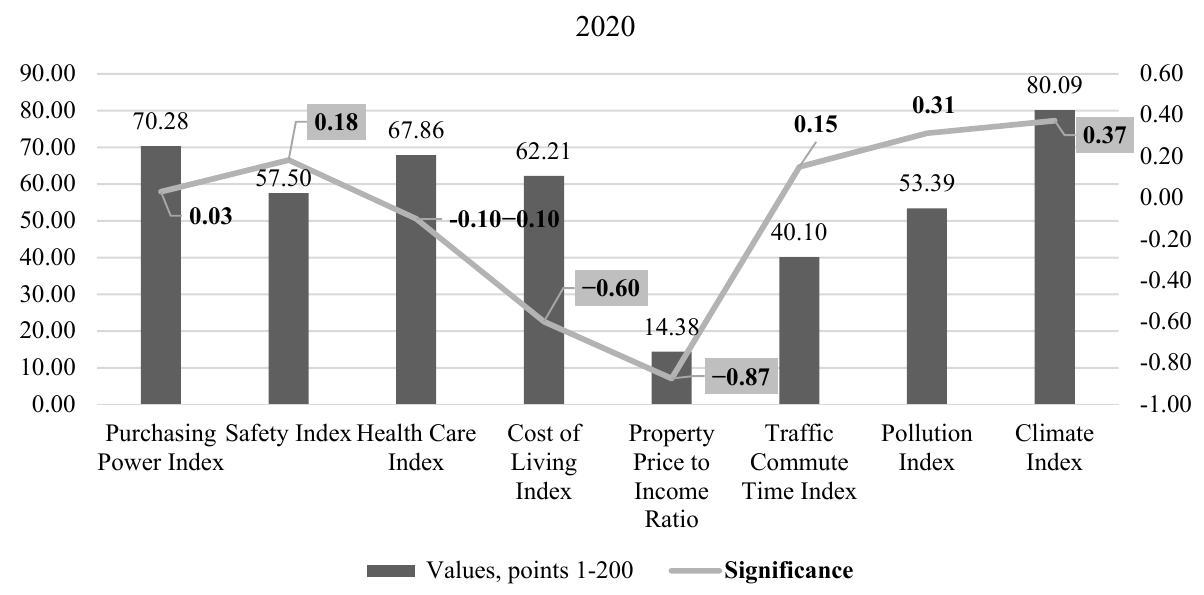
Figure 3. Arithmetic means of the indicators of quality of life and their regressive connection with smart cities in 2020. Source: calculated and built by the authors.